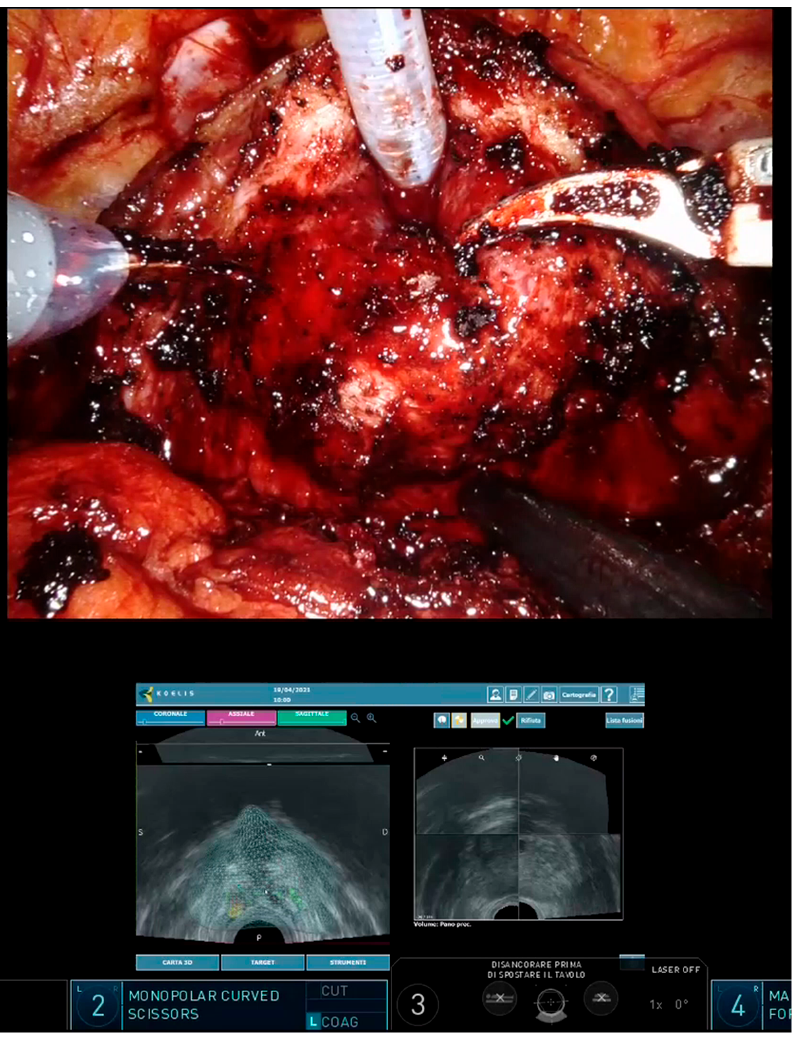
Figure 1. The 3D model is visualised live on the Da Vinci robotic console using the TilePro™ function, providing guidance during surgery.